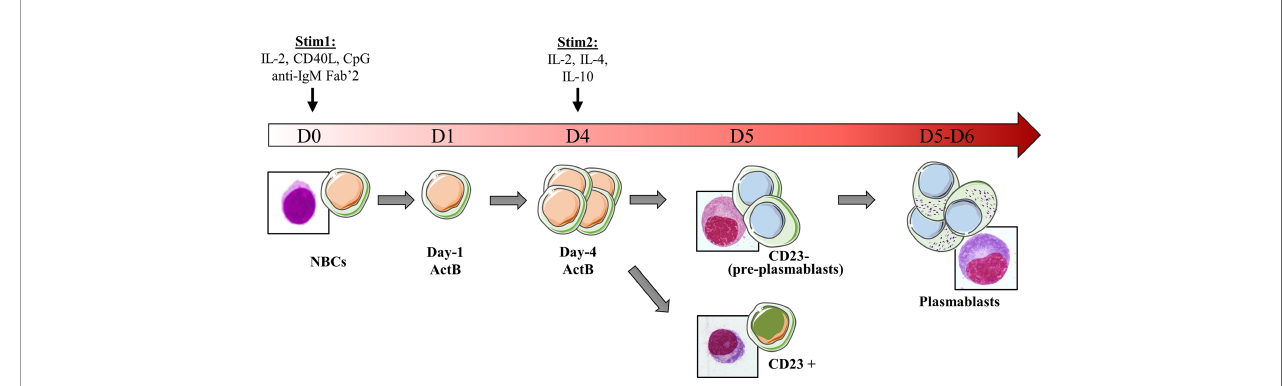
FIGURE 1 | Schematic representation of the in vitro model of B cells differentiation used in our laboratory. Peripheral NBCs from blood donors are stained with a cell- tracer then stimulated with IL-2, CD40L, CpG and anti-IgM Fab ’ 2. Day-1 activated cells are referred as day-1 ActB. After 4 days, activated B cells that have proliferated (Day-4 ActB) are selected according cell-tracer dilution and stimulated with IL-2, IL-4 and IL-10 to induce their differentiation into plasmablasts. The day after (D5), three populations are detected: (i) CD23+ cells that are stuck in an activated state and unable to differentiate, (ii) CD23- population, containing precursors of plasmablasts (pre-PB) which give rise to (iii) differentiated plasmablasts (PB). The increase in the cytoplasm/nucleus ratio, characteristic of the development of the Ig production machinery in PB, is early detected in the pre-PB stage. RNA-seq data are available for NBC, Day-1 ActB, Day-4 ActB, CD23+, CD23- and PB